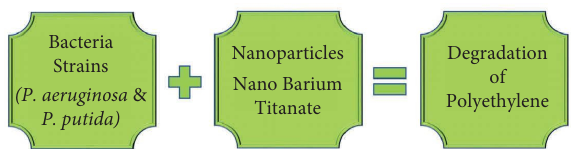
Figure 7: Mechanism of nanoparticles-base polyethylene degra- dation using microorganisms